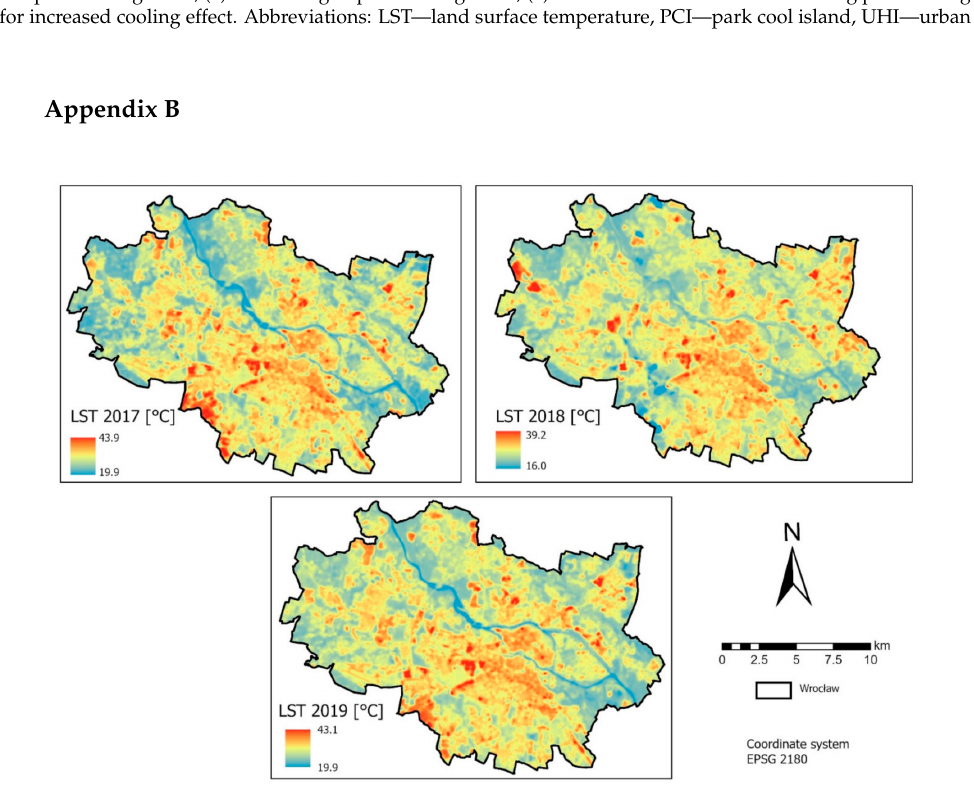
Figure A1. LST maps in Wroclaw for the analysed 2017–2019